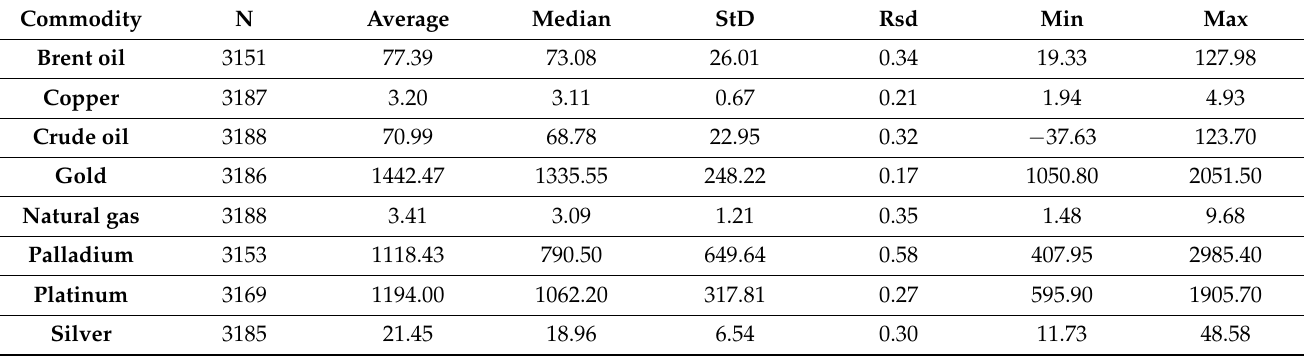
Table 6. Descriptive statistics of variables.